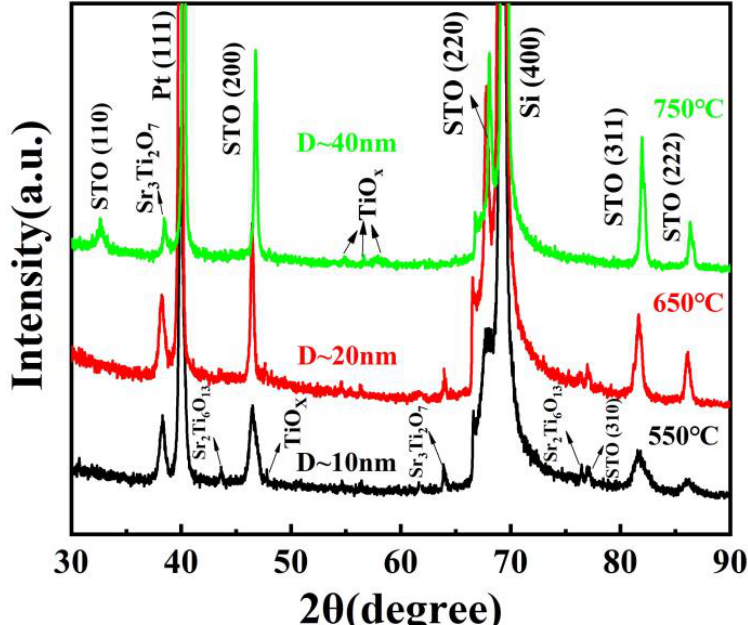
Figure 2. XRD patterns of the STO thin films annealed at different temperatures.